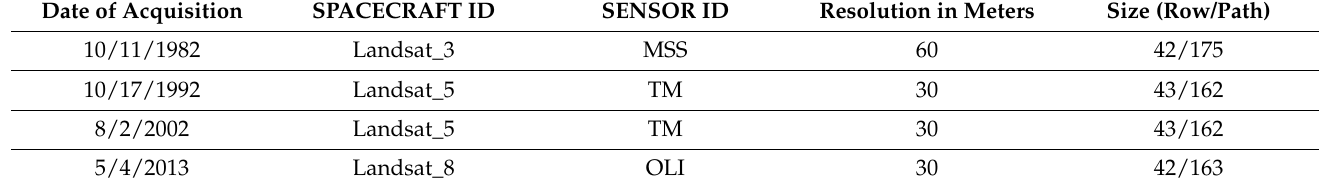
Table 2. List of satellite images used in this study, showing their properties.